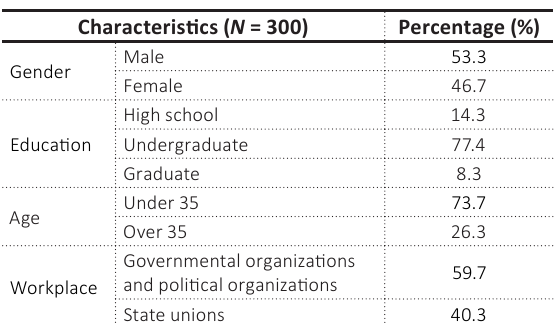
Table 1. Demographic